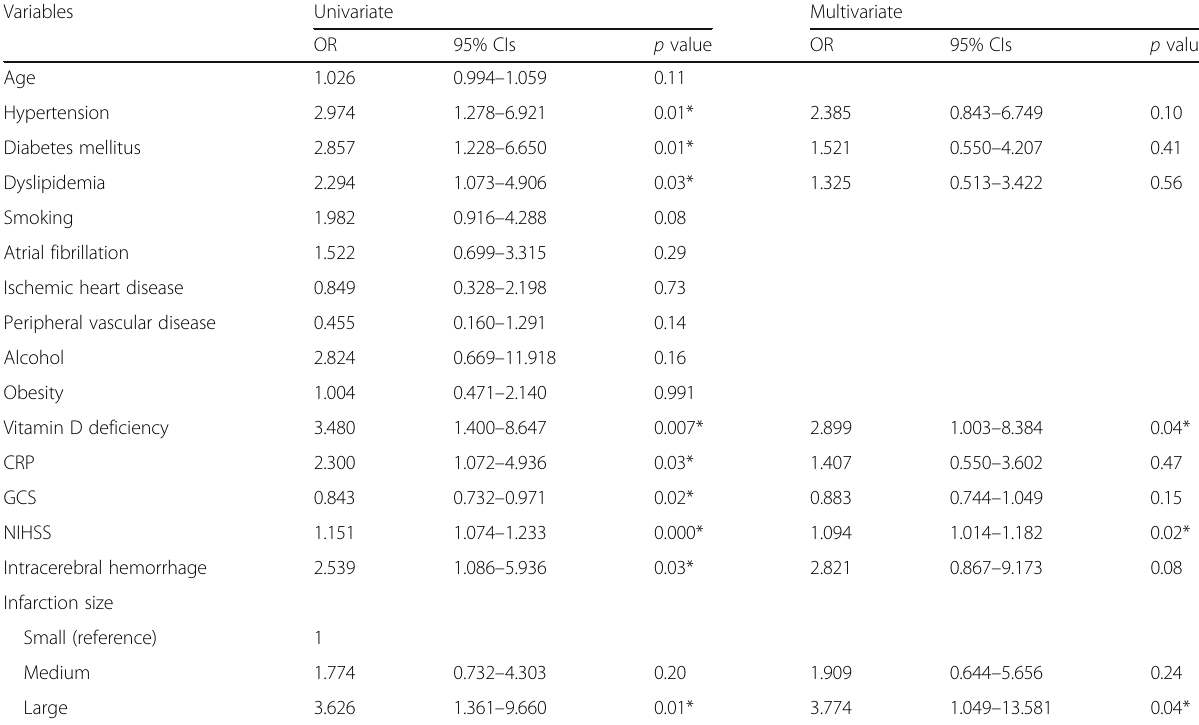
Table 3 Univariable and multivariable logistic regression analysis of factors with stroke outcome (mRS)